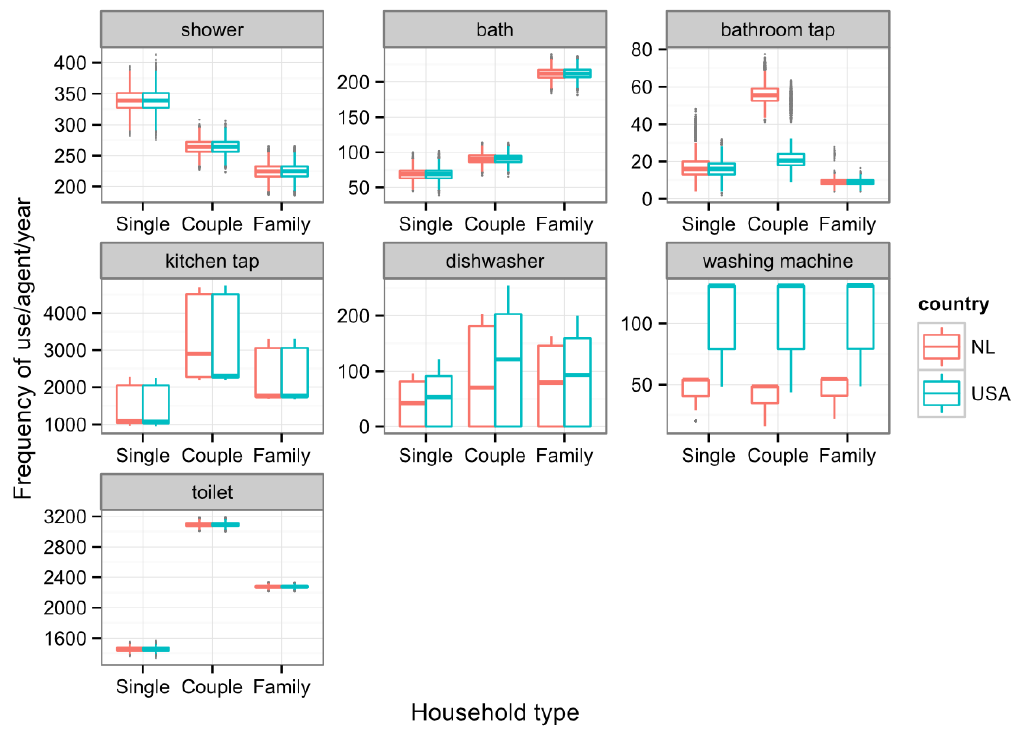
Figure 7. Distribution of fixture and appliance use frequency per year per water fixture and per household type. The differences in frequencies of use are the consequence of differences in agent